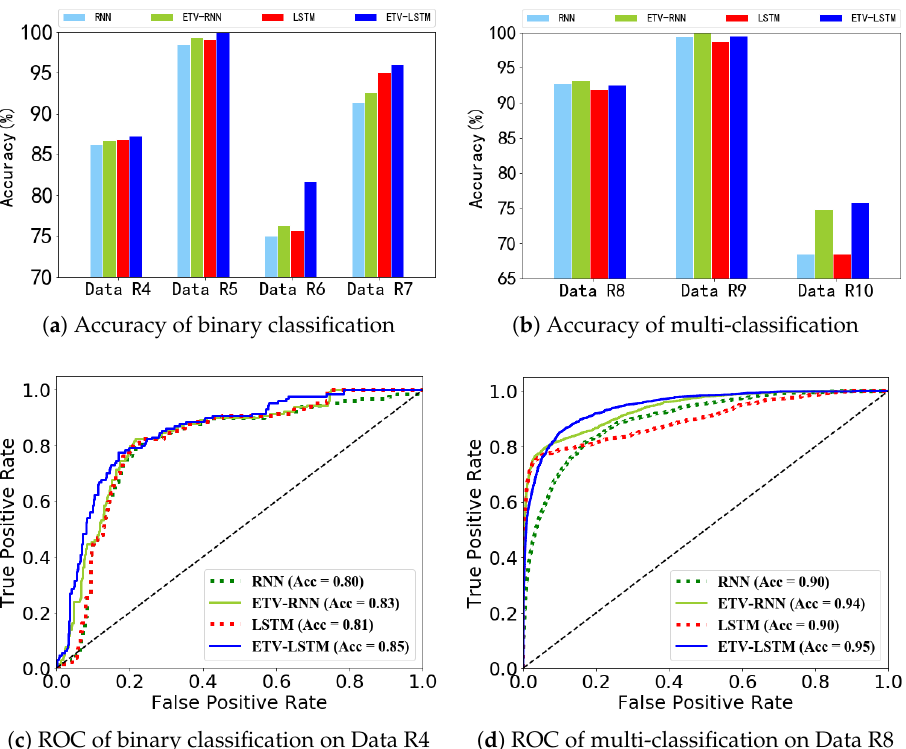
Figure 9. Comparison of classification accuracy and ROC curves over RNN, ETV-RNN, LSTM, and